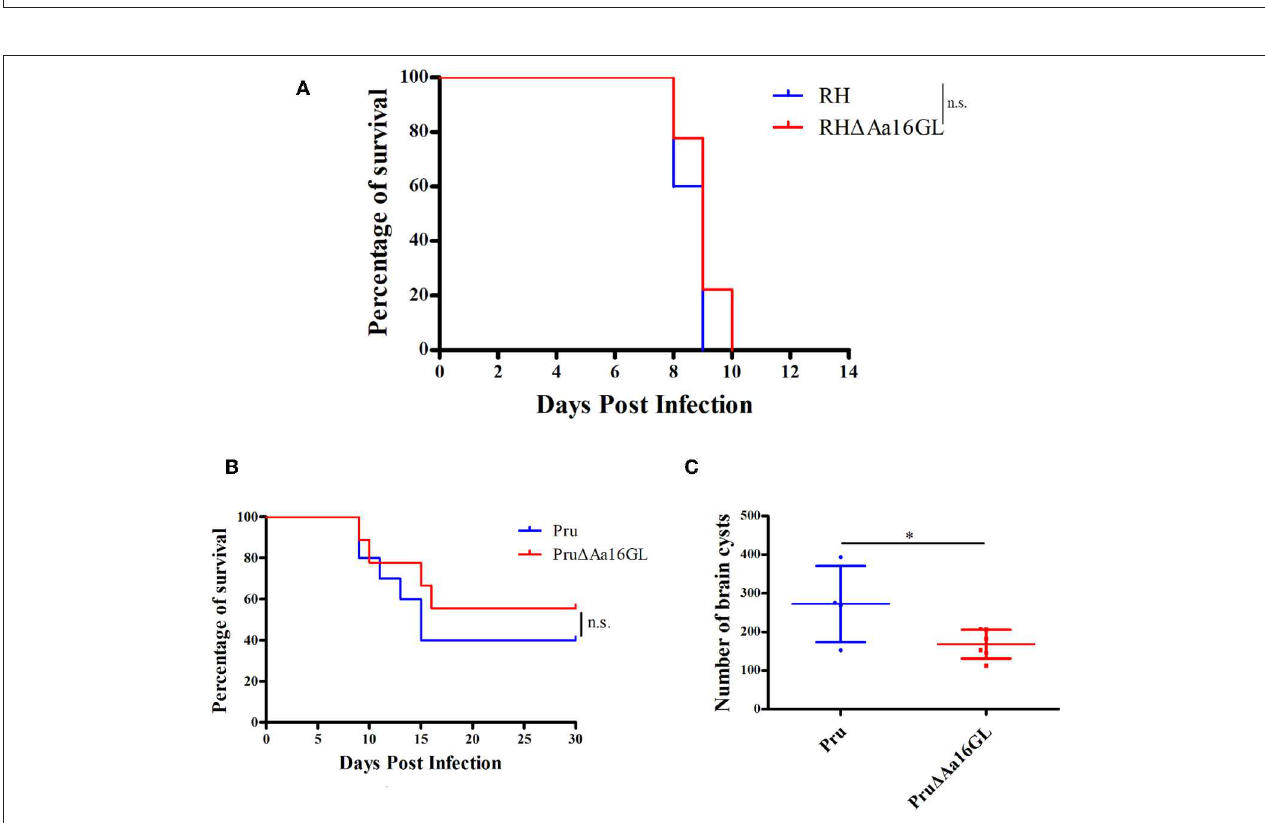
FIGURE 7 | Virulence of amylo-alpha-1,6-glucosidase-deficient strain in mice. (A) C57BL/6 female mice (10/group) were intraperitoneally (i.p.) infected with 100 parental RH or RH 1 Aa16GL tachyzoites, and the survival of mice was monitored until all the mice died (Gehan–Breslow–Wilcoxon tests. n.s. = not significant). (B) C57BL/6 female mice (10/group) were i.p. infected with 5 × 10 3 freshly harvested tachyzoites of Pru or Pru 1 Aa16GL strain. Subsequently their survival was observed for 30 days (Gehan–Breslow–Wilcoxon tests. n.s, not significant, Student’s t -tests). (C) The number of brain cysts in mice was evaluated at day 30 post infection. * P < 0.05, Student’s t